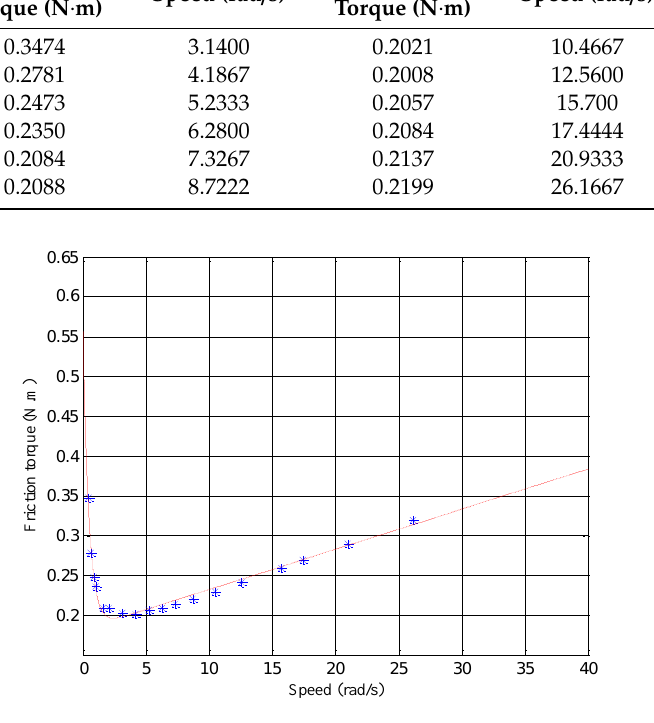
Figure 6. Fitted Stribeck curve of a RV reducer. Table 2. Fitted parameters of the Stribeck model of a RV